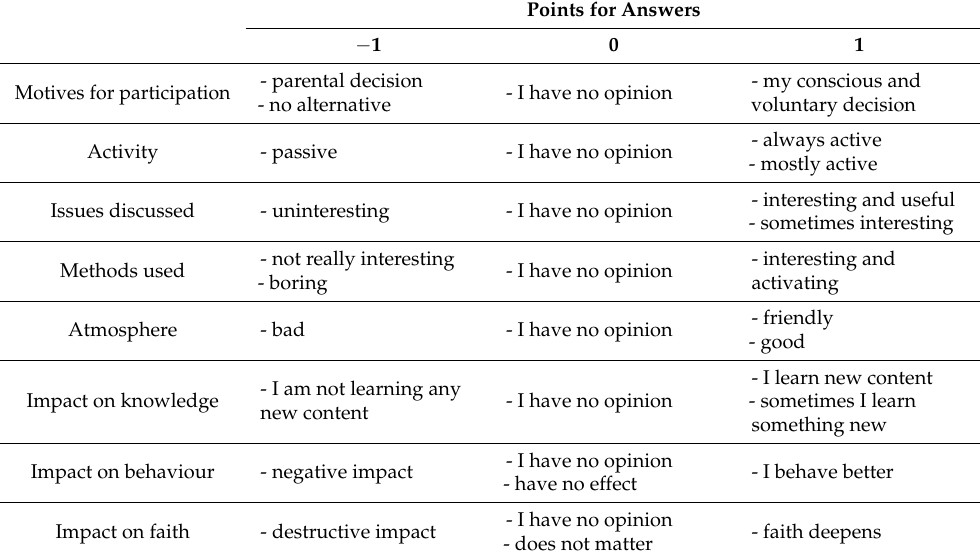
Table 2. Index of attitudes towards religious education